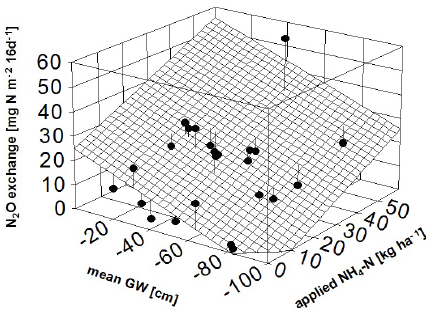
Figure 6. Relationship of plot-wise mean 16 days’ cumu- lative N 2 O–N emissions of the four application events ( y ) to mean groundwater level ( x 1) and the amount of ap- plied NH 4 –N ( x 2). The regression equation is y = 24.98 ( ± 4.98) + x 1 · 0.30( ± 0.09) + x 2 · 0.51( ± 0.11); R 2 adj. = 0.53, P < 0 . 001, d f = 21. Solid lines indicate the deviation of measured data from the model surface.